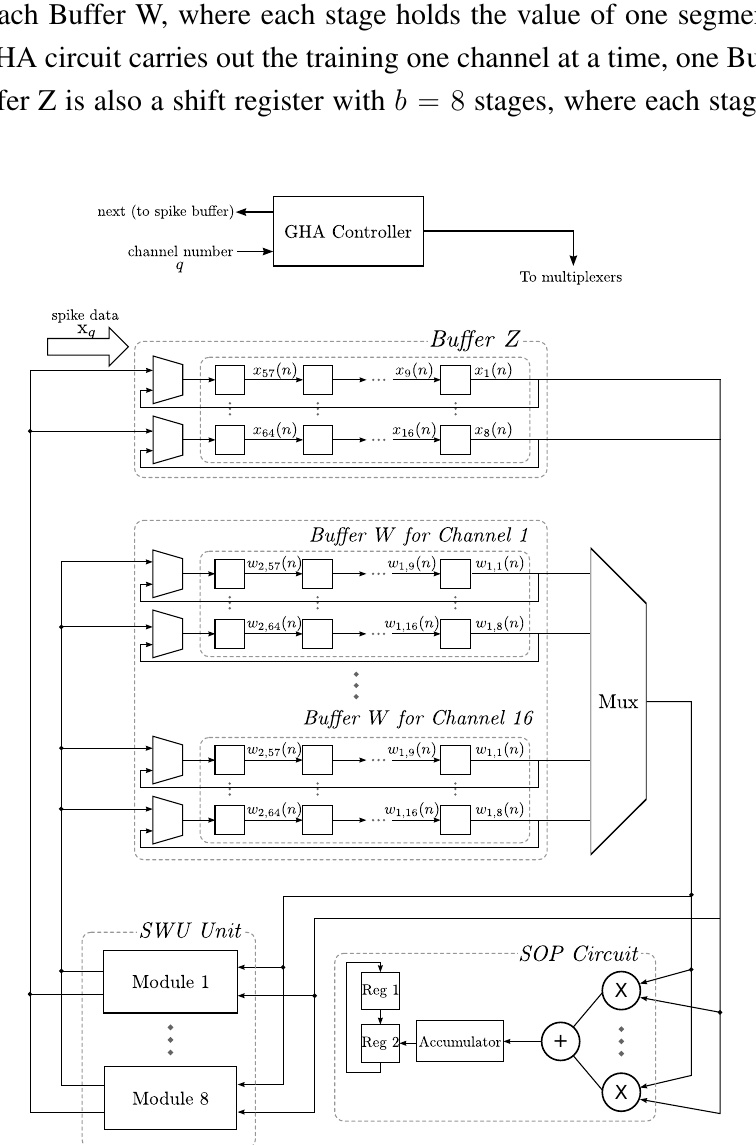
Figure 9. An example of the multi-channel GHA circuit for feature extraction with two principal components ( p = 2 ) and 16 channels ( M = 16 ). There are eight modules in the SWU unit and eight multipliers in the SOP circuit ( L = 8